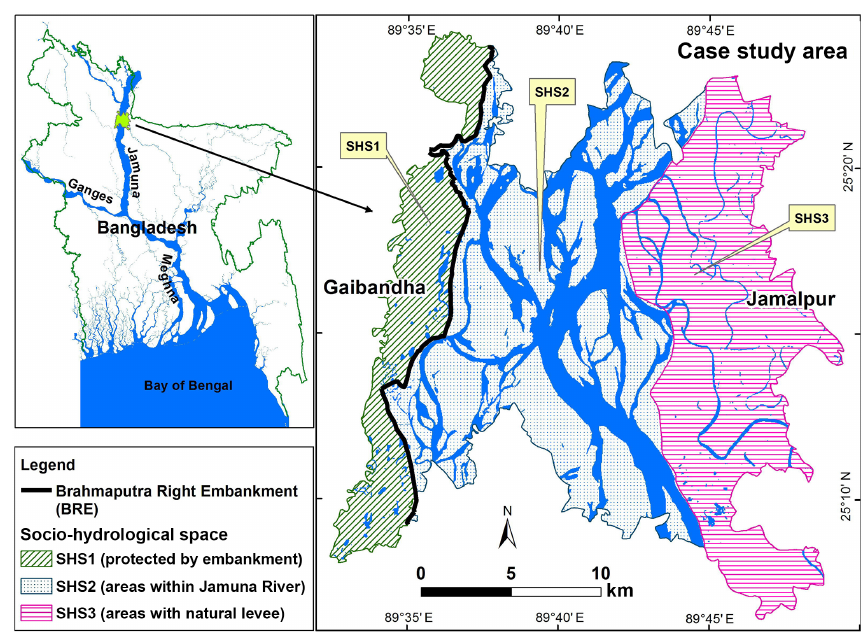
Figure 2. Bangladesh map with case study area and